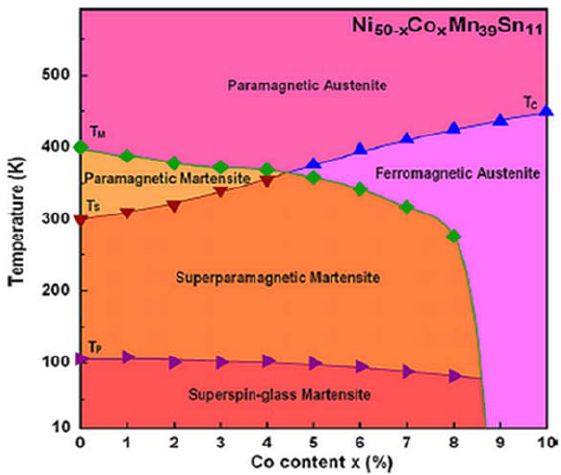
Figure 5. Phase diagram of Ni 50 − x Co x Mn 39 Sn 11 (0 ≤ x ≤ 10) alloy system [38], with copyright from © Elsevier . permission from ©